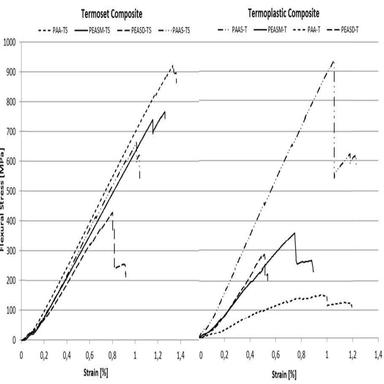
The average flexural stress-strain curves of the advanced composites.